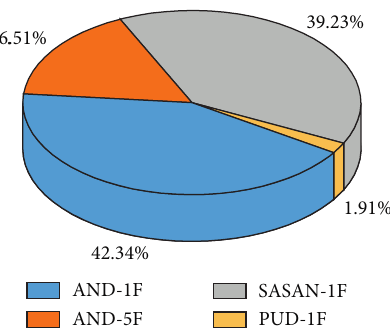
Figure 11: Temporal distribution of arrival